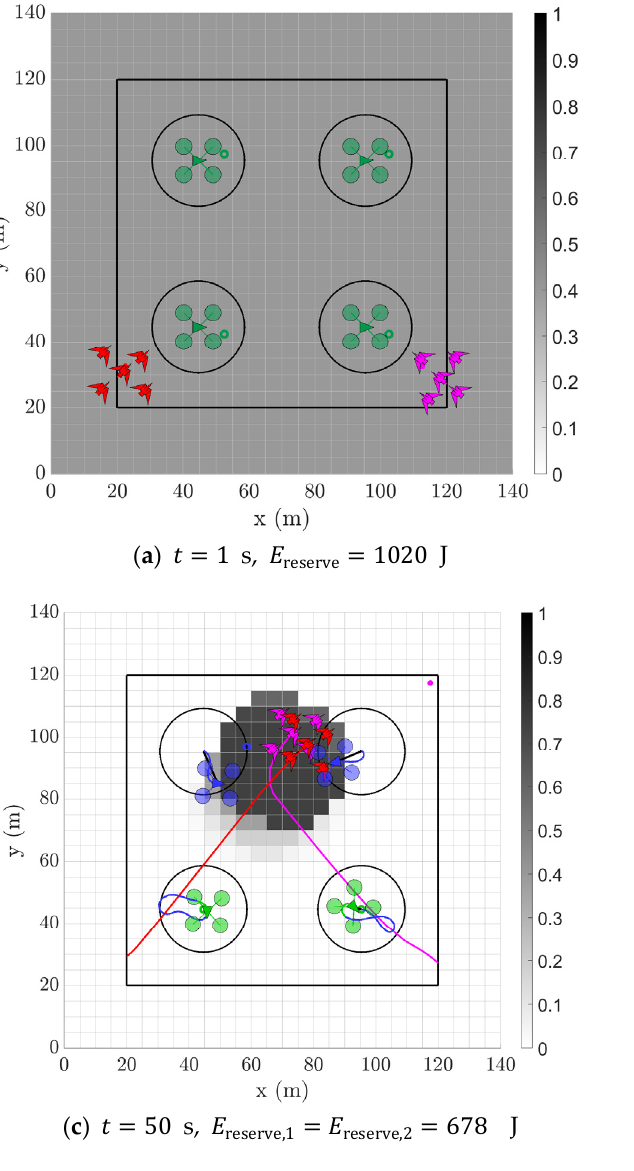
Figure 13. Snapshots of a sample double target flock simulation with the following configuration: n = 4 agents, R T = 14 m, v max = 12 m/s. Simulation begins in ( a ) with each target in their respective target flock at the full energy reserve of 1020 J, all agents undeployed in their Home state, and each cell in the probability map initialised with the same value. As the simulation progresses from ( b , c ), both target flocks seek to find grid cells of maximum interest indicated by their respective red ( Flock 1 ) and magenta ( Flock 2 ) dots but are repelled by nearby deployed agents, shown in their Chase state, while agents that were deployed but no longer in range are shown in their Return state. Simulation is completed in ( d ) with both target centres (greyed out) no longer in the protected area at the same time of 𝑡 = 79 s and the original energy reserve approximately halved.